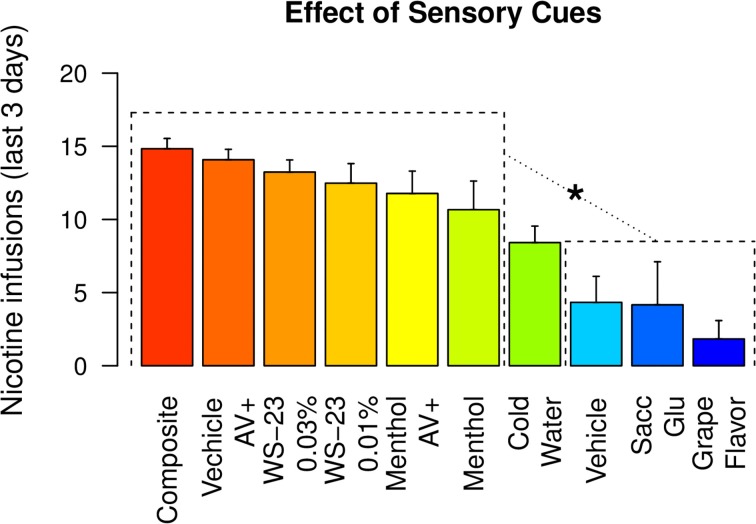
The amount of nicotine intake with different sensory cues. The amounts of nicotine infusions obtained during the last three IVSA sessions with 10 different sensory cues were plotted. Any of the six highest groups were statistically different from any of the three lowest groups. *
p < 0.05, Tukey's HSD test.